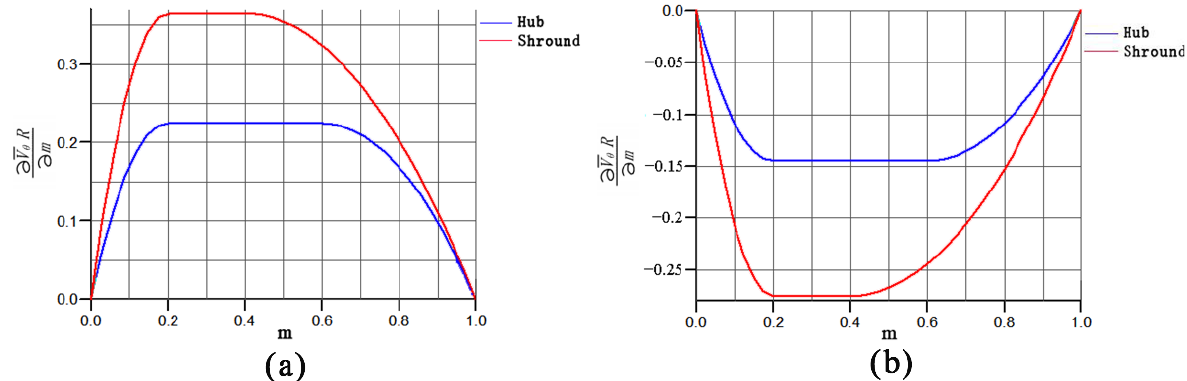
Figure 26. The load of the rotor and stator blades ( a ) Load of the rotor, ( b ) Load of the stator blades [103].